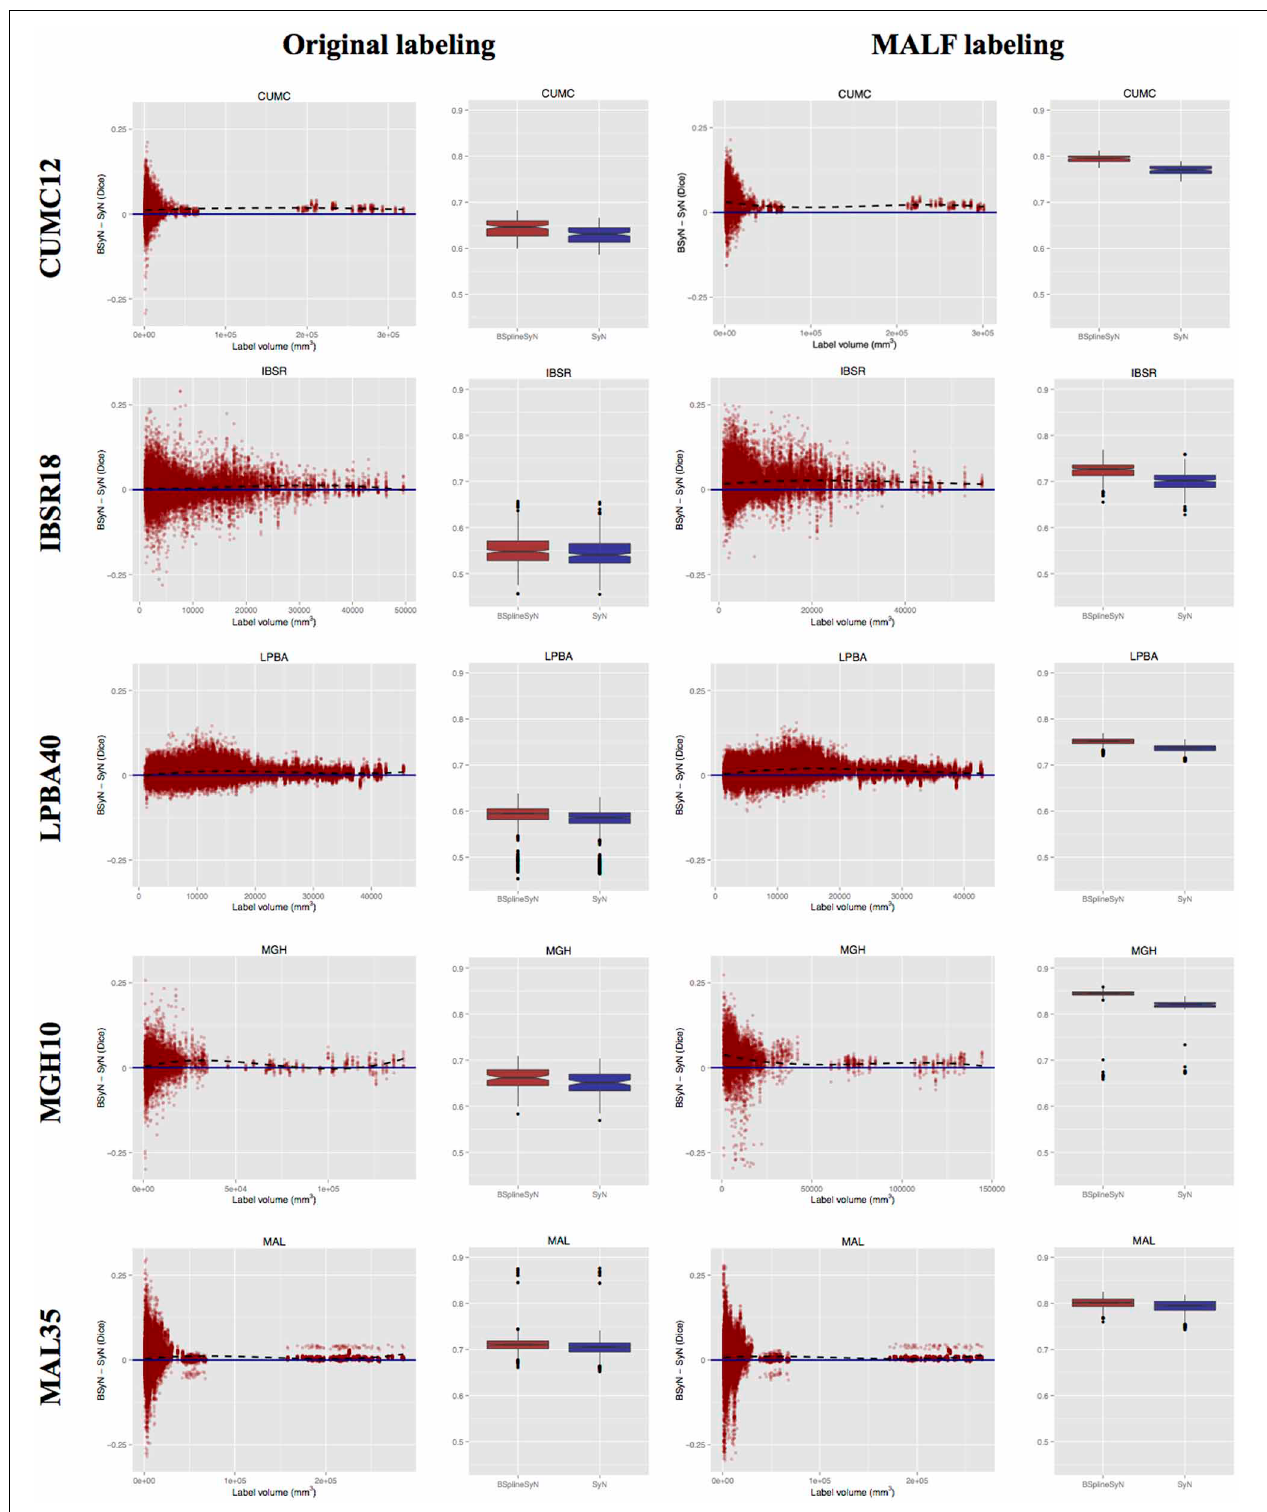
FIGURE 5 | Dice results for both algorithms for each subject warped to every other subject using the pseudo- geodesic transform. Each row corresponds to one of the five data sets used for evaluation. For each data set we include a plotting of all individual label Dice results by volume and a